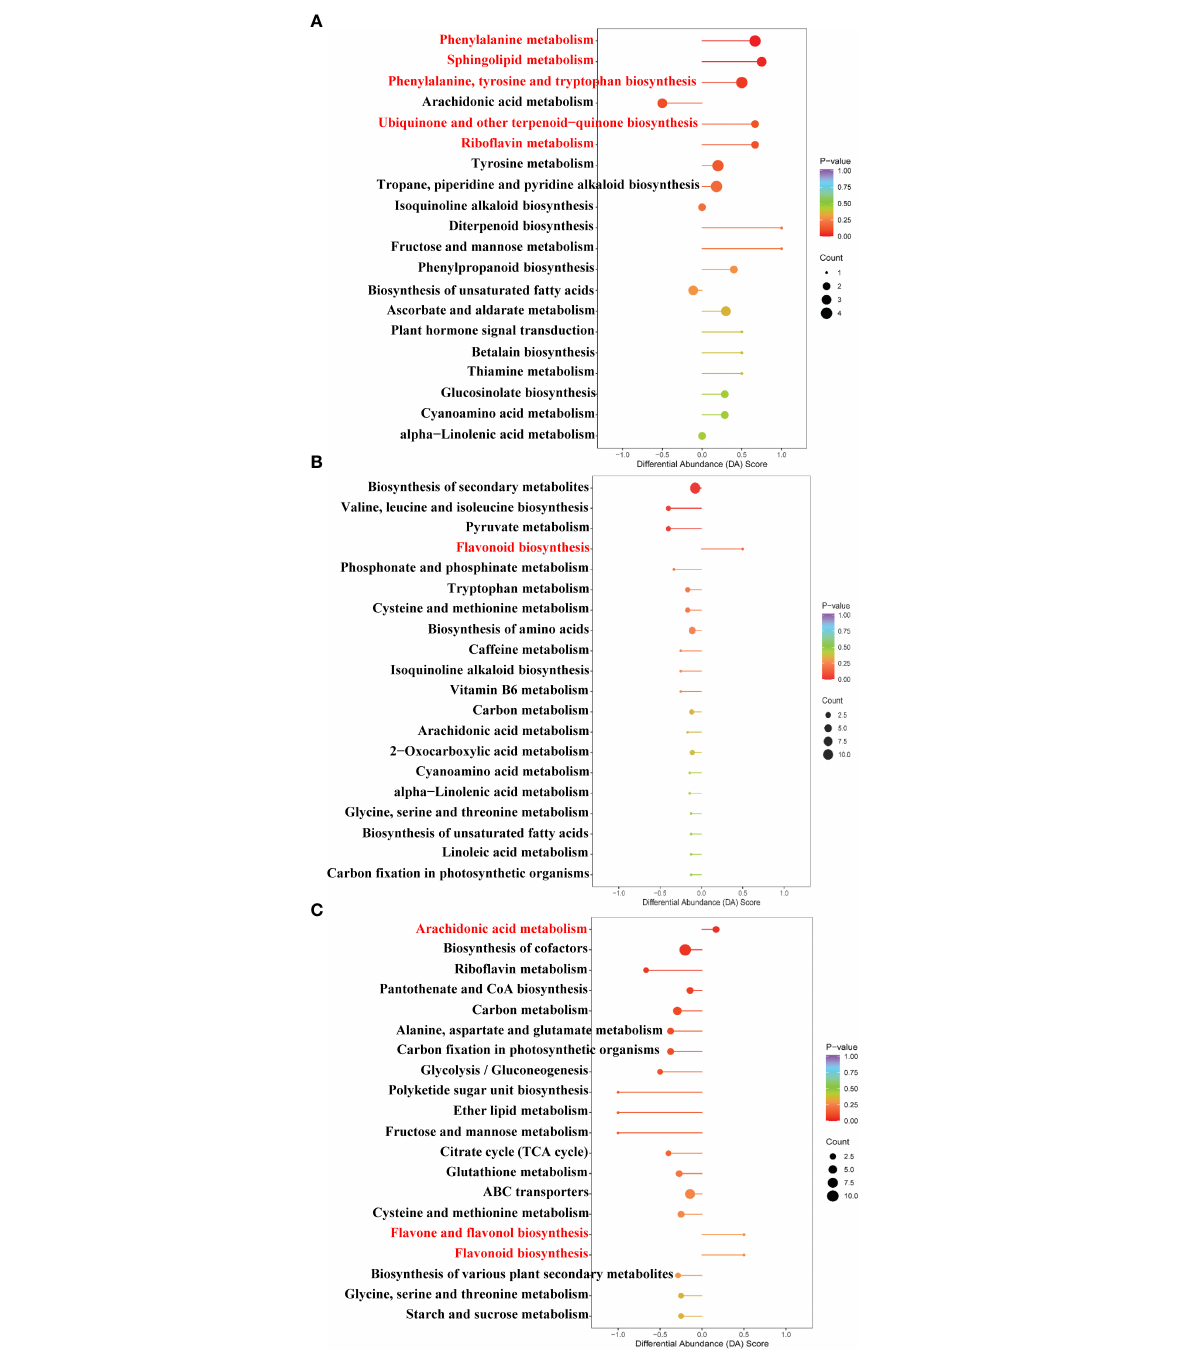
FIGURE 7 Bubble chart of the top enriched metabolic pathway under different treatments: (A) Cd treatment vs. control, (B) La treatment vs. control, (C) Cd + La treatment vs. Cd treatment. The ordinate is the name of the metabolic pathway; the abscissa is the DA Score (the differential abundance score). DA Score extending to the right indicates that the pathway is up-regulated, otherwise indicates that the pathway is down-regulated. A larger dot indicates that more metabolites are enriched in that pathway. The colour from purple to red indicates that the p-value decreases. The red letters denote metabolic pathways for subsequent